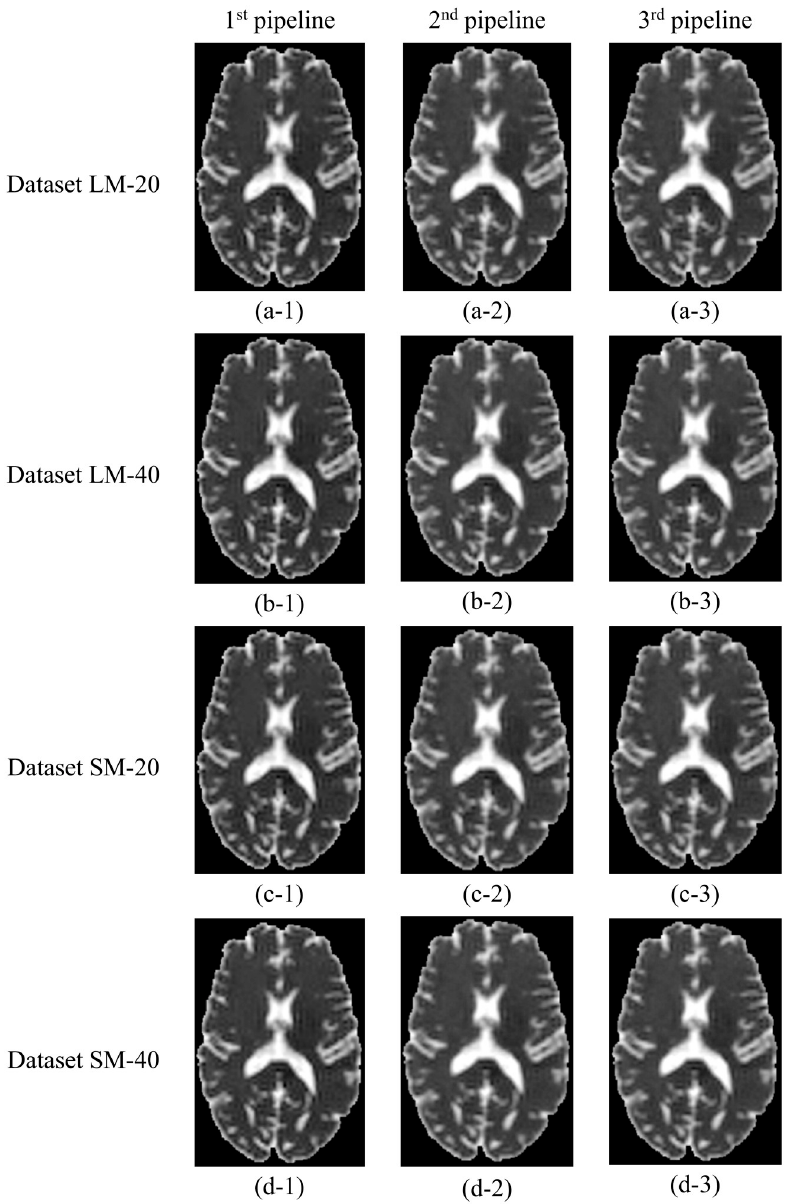
1 -weighted structural image and full-brain segmentation of cerebral tissues are provided in panels e and f of Fig 2, respectively. The images were not